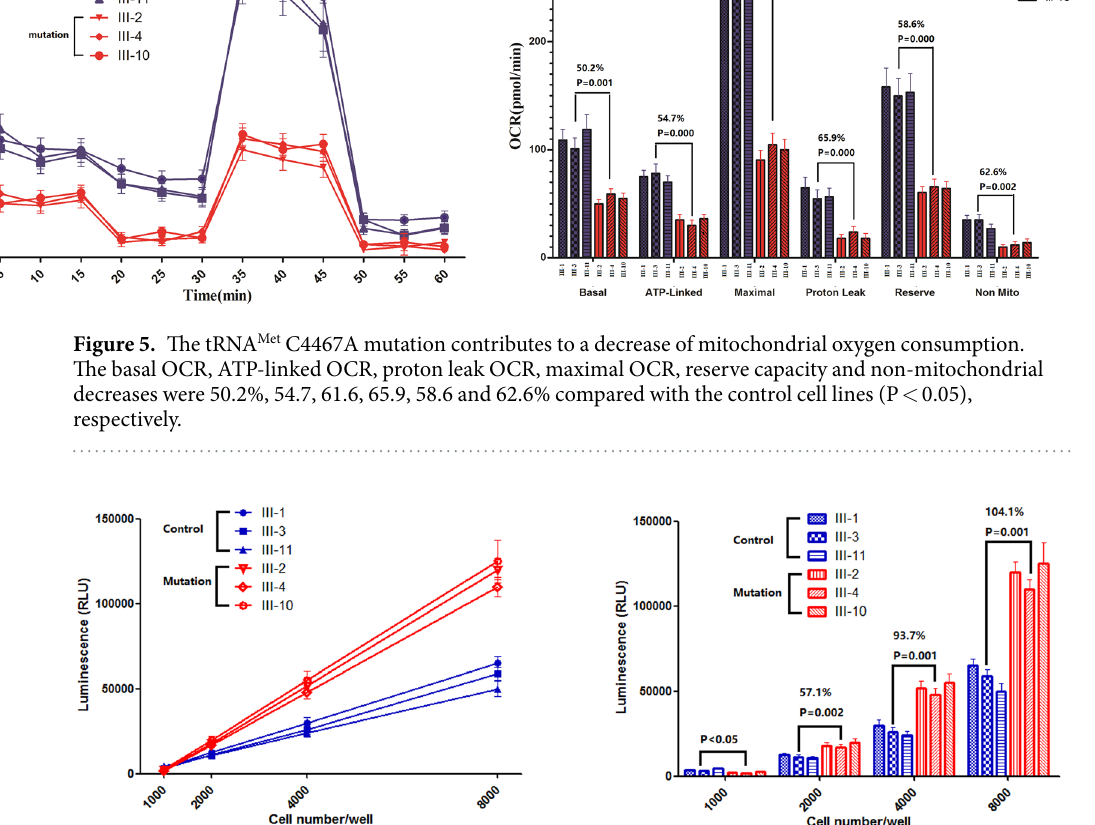
Figure 6. Caspase 3/7 activity evaluation. The lymphocyte cells lines were harvested and examined using a Caspase-Glo 3/7 assay kit according to the manufacturer’s instructions. Caspase-3/7 activity in the mutant cell lines was significantly increased by 57.1% in the 2 × 10 3 cell group, 93.7% in the 4 × 10 3 cell group, and 104.1% in the 8 × 10 3 cell group compared with control cell lines ( P <